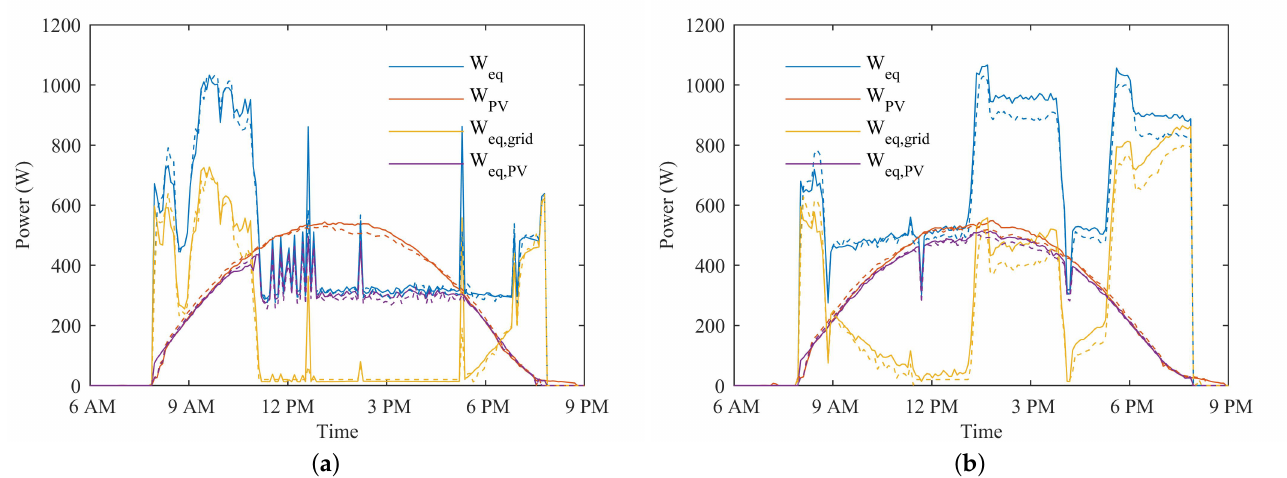
Figure 5. Experimental (solid, Aguilar et al. [8]) and simulated (dashed) electrical curves registered along: ( a ) the 31 July and ( b ) the 2 August. Reprinted from Aguilar et al. [8] with permission, 2017,